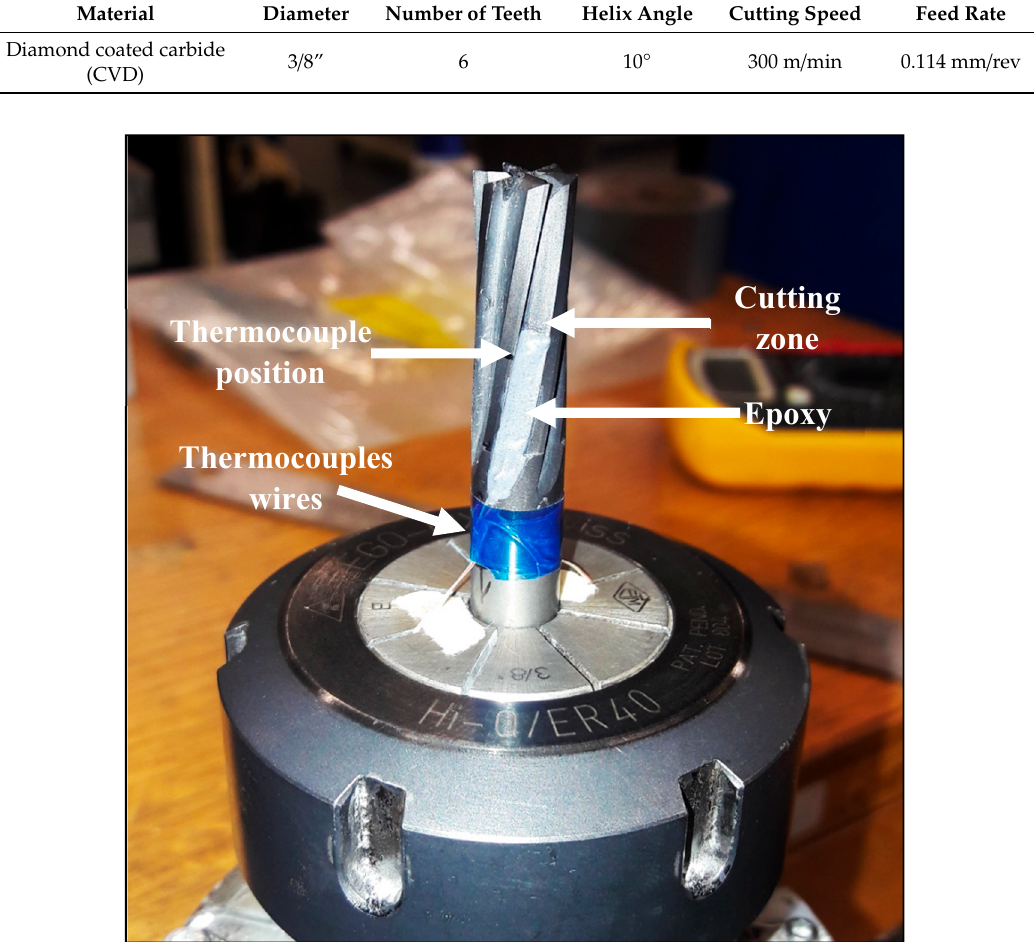
Figure 5. Equipped tool.